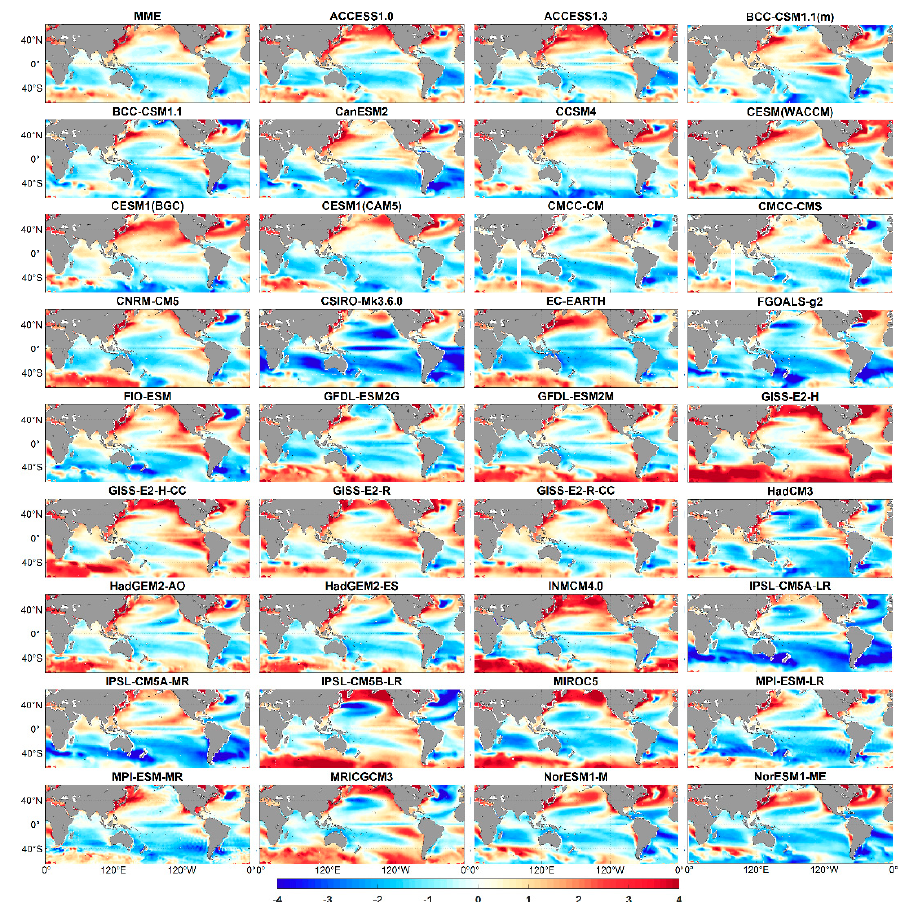
Figure 1. Biases (°C) of the observed and simulated average sea surface temperatures (SSTs), including those produced by the MME (computed by averaging across all models) from 1901 to 2005 during winter (the model name is at the top of each figure, and the subsequent figures are labeled in the same way).